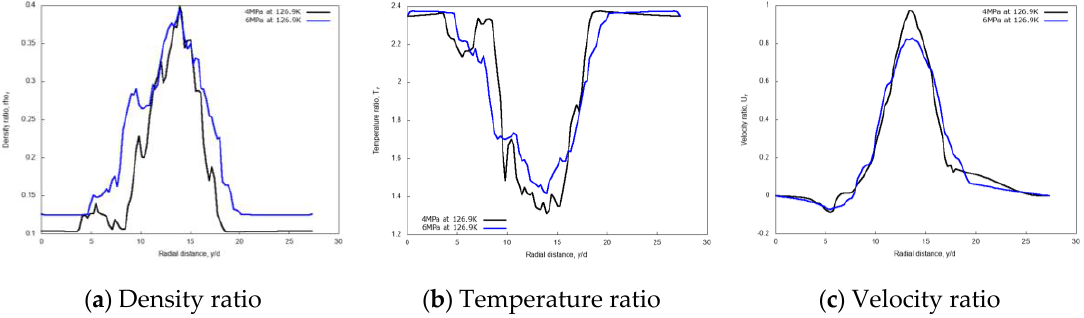
Figure 10. Radial profiles of non-dimensional density, temperature, and velocity at fixed axial distance x / d = 20, for different chamber pressures: 4 MPa and 6 MPa. Simulations of cryogenic L-N 2 injected at 126.9 K and 4.9 m/s into G-N 2 at 298 K.